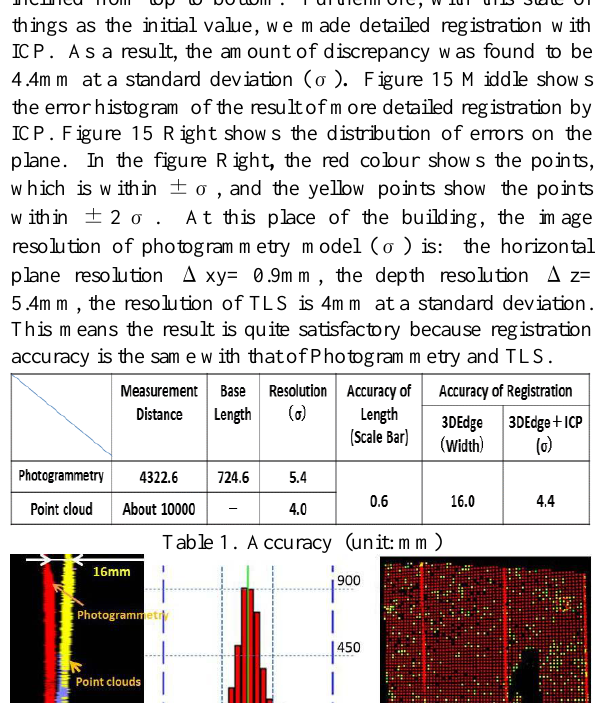
Table 1. Accuracy (unit: mm)